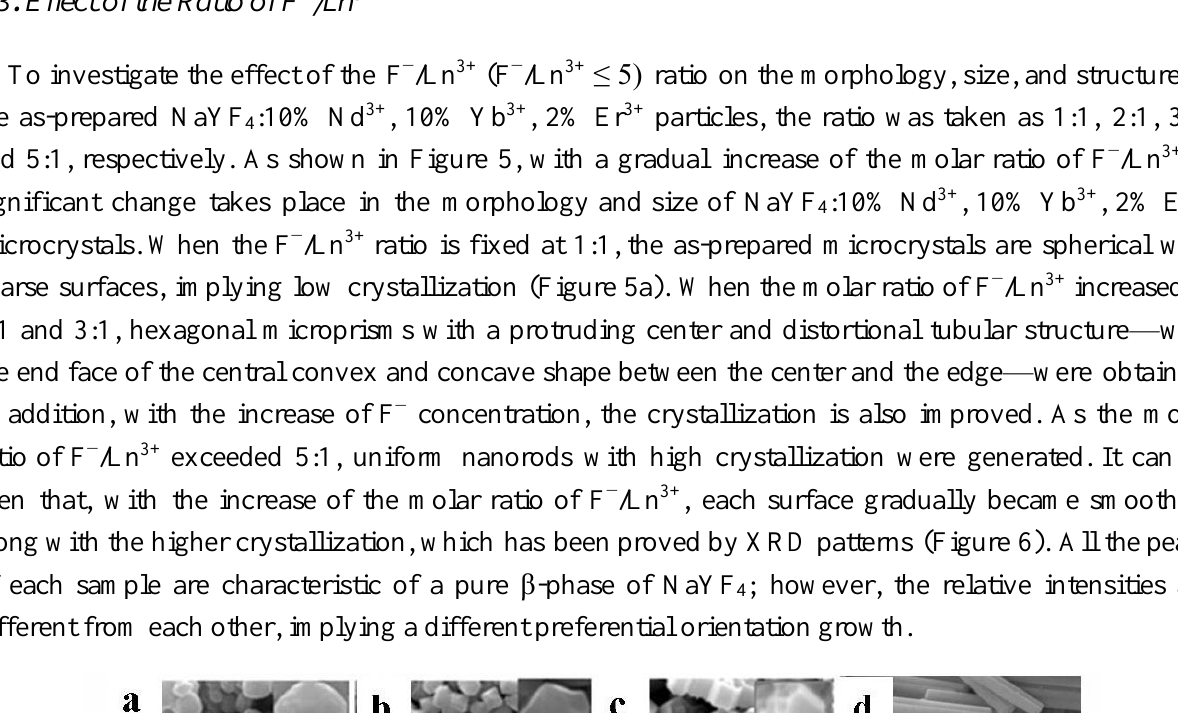
:10% Nd 3+ , 10% Yb 3+ , 2% Er 3+ 4